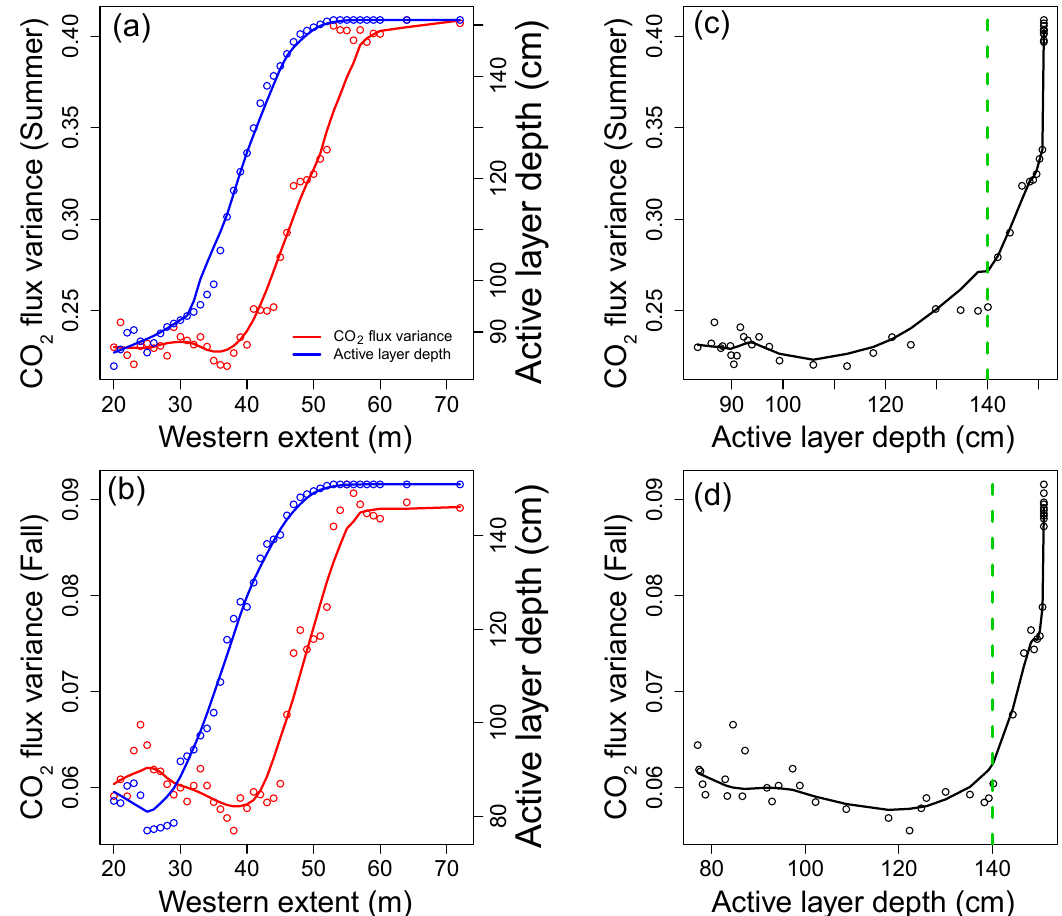
Figure 4. Relationships among soil respiration variance (CO 2 flux variance), active layer depth, and space. (a, b) Each soil respiration variance estimate (red plot, left-side axis) is based on data from all soil collars within a spatial domain that extends from the field site’s eastern boundary to the indicated western-most spatial position (horizontal axis). Each active layer depth estimate (blue plot, right-side axis) is the mean active layer at the western-most spatial position. Lines are spline-fits. (c, d) Soil respiration variance as a function of mean active layer depth – both from panels (a) and (b) . The 140cm threshold is indicated by the vertical dashed green line. The black lines are spline-fits.